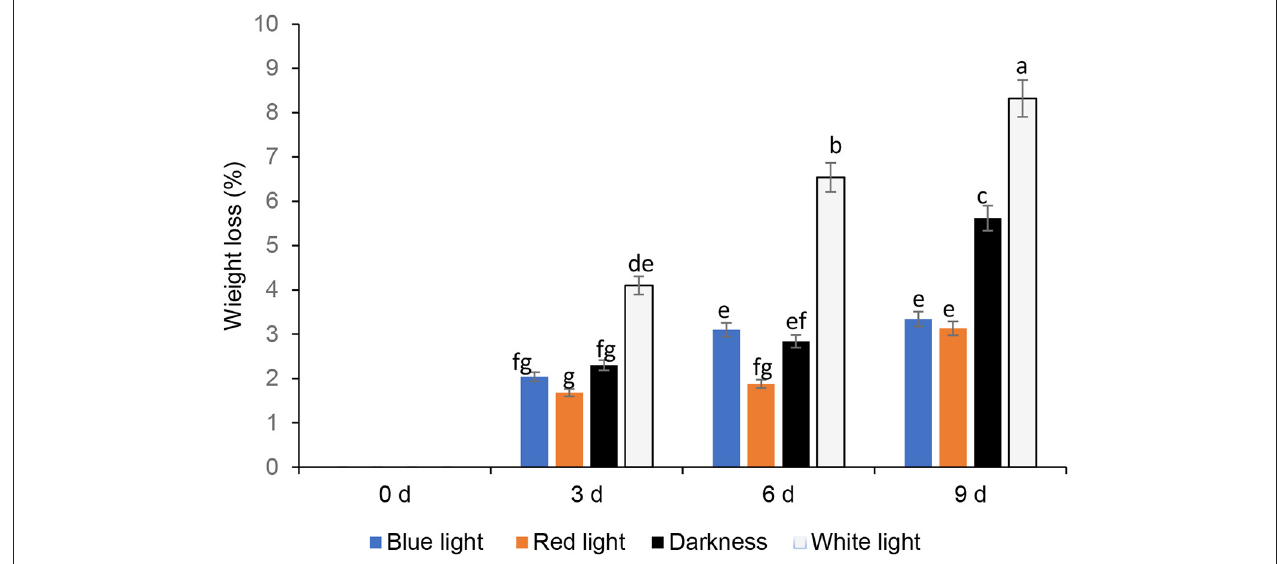
FIGURE 2 | Effect of blue and red LED light treatment on mass loss of coriander ( Coriandrum sativum ) leaves after post-harvest storage. Bars with the same alphabetic letter along the column are not significantly different at p ≤ 0.05.